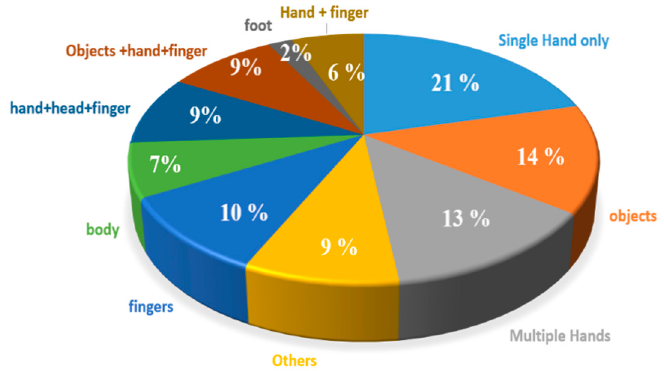
Figure 1. Usage of different body parts to make a human–computer interface (HCI)